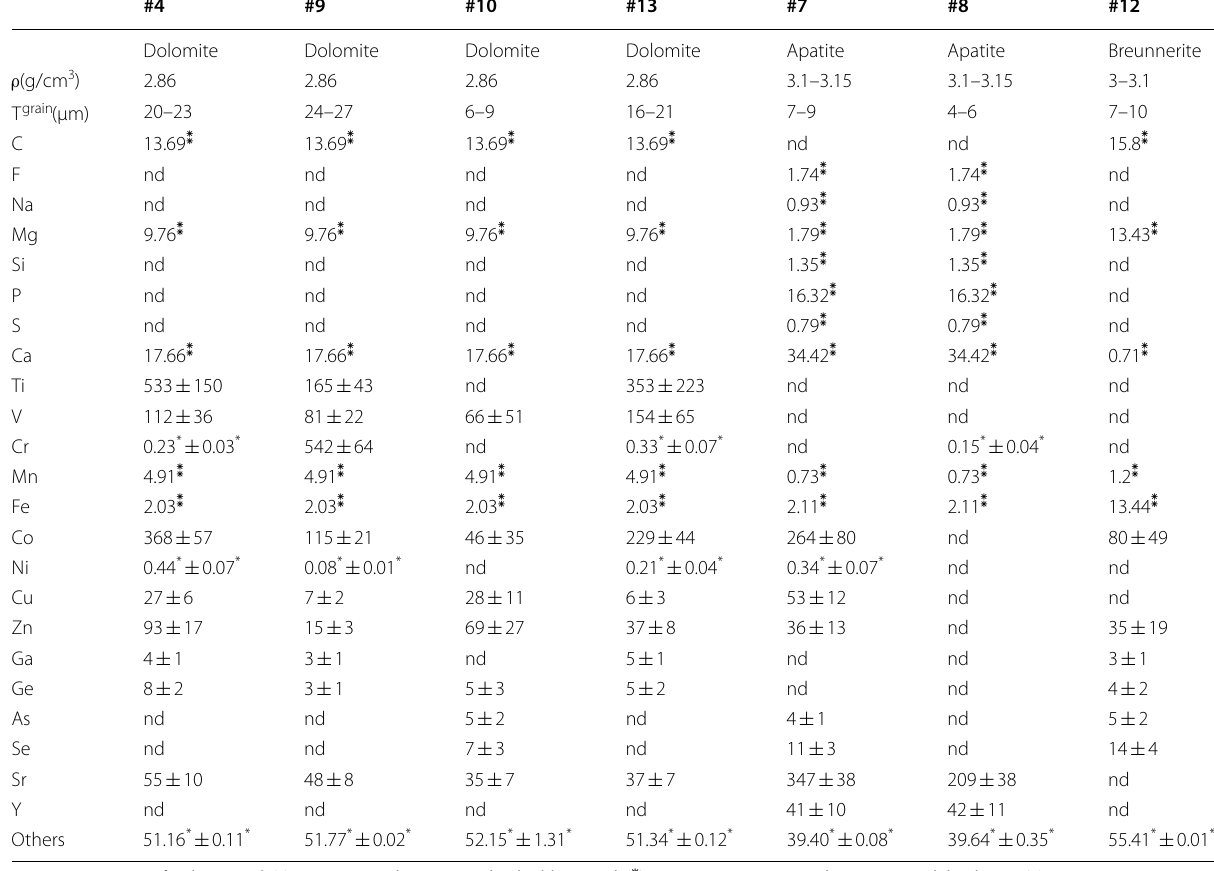
Data in ppm, except for the asterisk (*) representing data in wt%, the double asterisk ( ⁑ ) representing SEM–EDX data in wt% and the dagger (†) representing CI chondrite composition data from Lodders, 2010 in wt%. nd